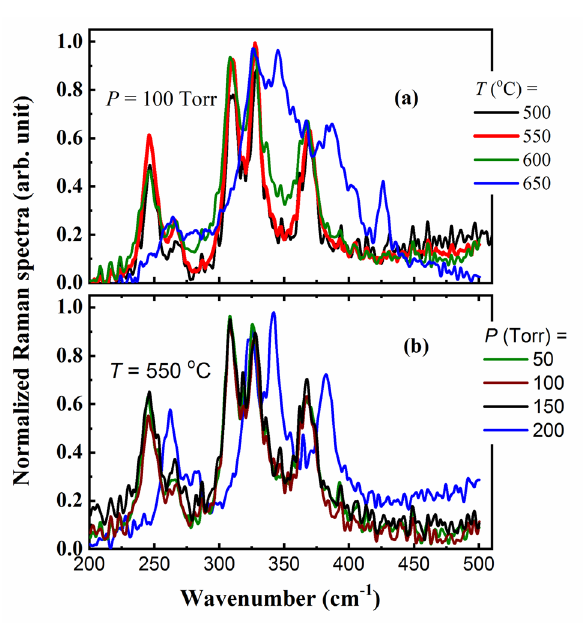
Figure 8. ( a , b ): The Raman spectra of In 2 S 3 ( a ) for samples growing at a pressure of 100 Torr and with different annealing temperatures (500, 550, 600, and 650 °C), and ( b ) the samples with the annealing temperature of 550 °C and with different higher pressures (50, 100, 150, and 200